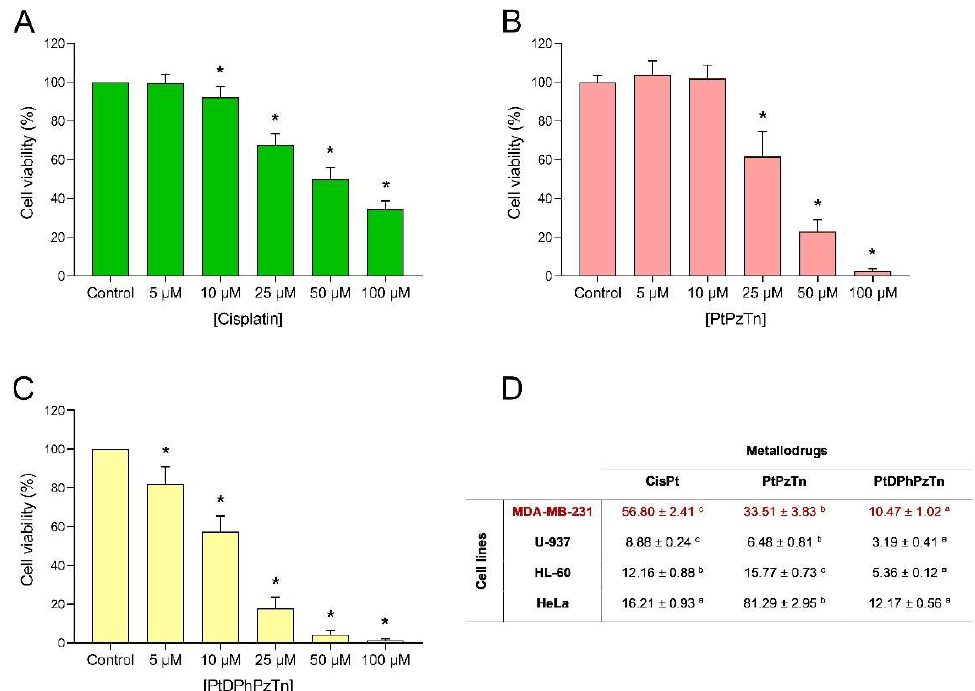
Figure 1. Dose–response curves of metallodrugs on cell viability. MDA-MB-231 cells were treated for 24 h with increasing concentrations (0–100 µ M, as indicated) of cisplatin ( A ), the platinum(II) complexes PtPzTn ( B ) and PtDPhPzTn ( C ), or the vehicle (DMF, control). Data represent means ± S.D. of 6 independent experiments and are expressed as percentage of control values. * p < 0.05 compared to their corresponding control values (Dunnett’s test). ( D ) IC 50 values (mean ± S.D., µ M) of cisplatin (CisPt), PtPzTn, and PtDPhPzTn against MDA-MB-231, U-937, HL-60, and HeLa cell lines. Within each row, values followed by a diverse lowercase letter (a–c) are significantly different ( p < 0.05; Tukey’s test).